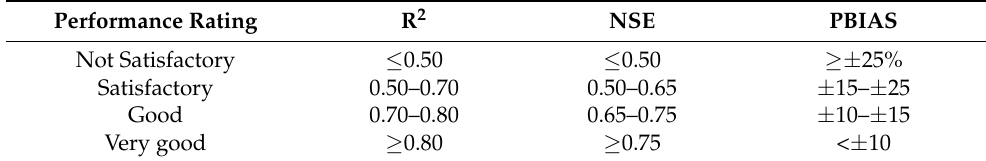
Table 3. General criteria for performance evaluation in a statistical test at the watershed scale